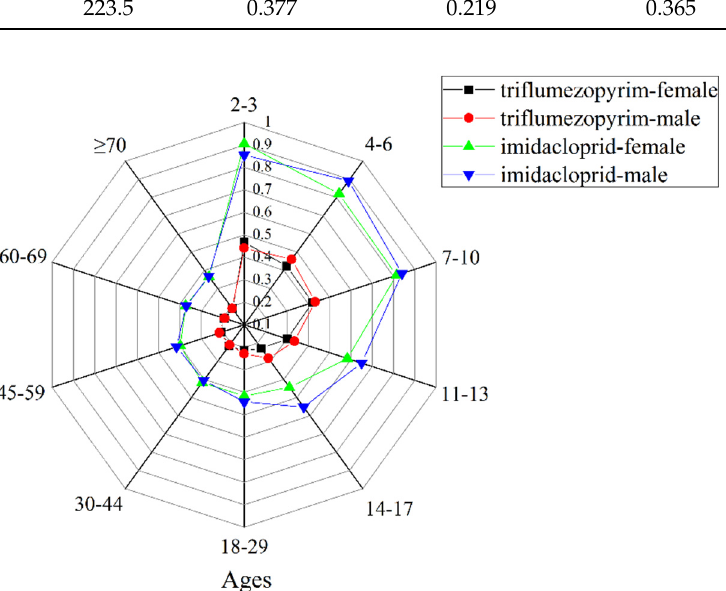
Figure 6. Risk quotient (RQ) of triflumezopyrim and imidacloprid in rice for the different ages and sexes.